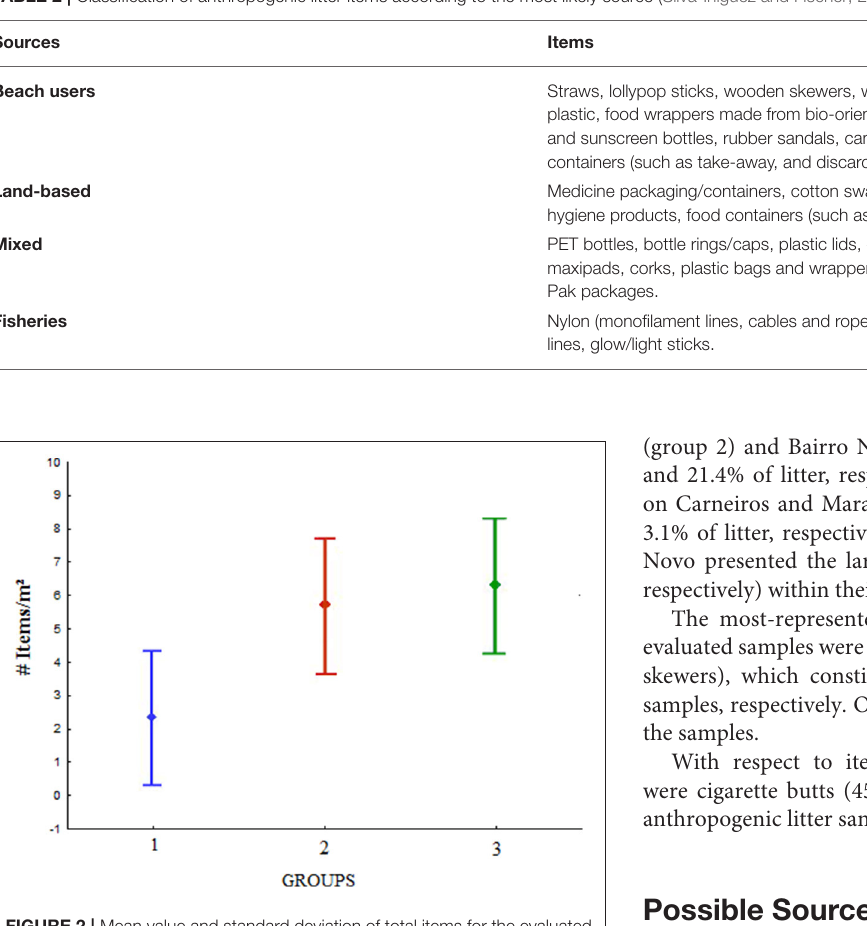
FIGURE 2 | Mean value and standard deviation of total items for the evaluated groups (1, 2, and